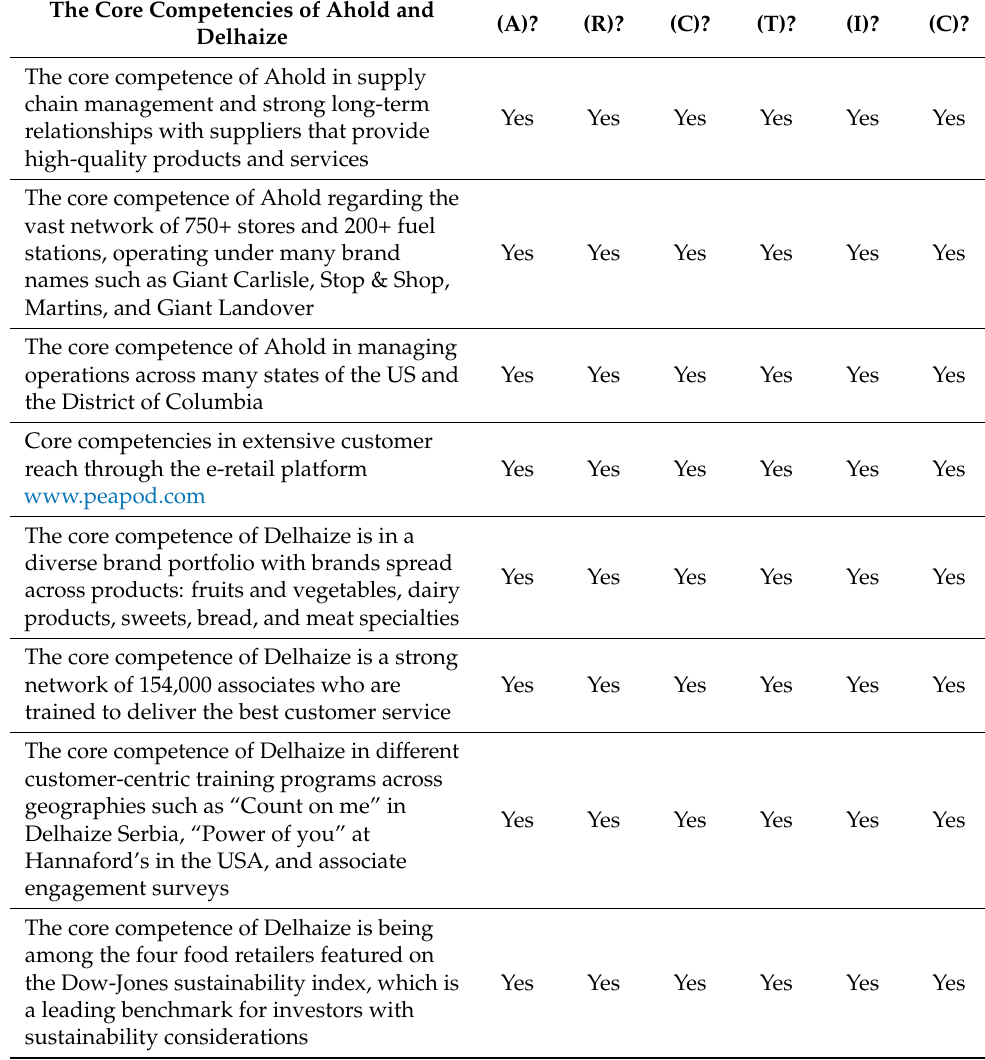
Table 3. The ARCTIC framework: analysis of compatibility, complementarity, and transferability of core competencies of the Ahold Delhaize deal as prerequisites of explicit competence-based